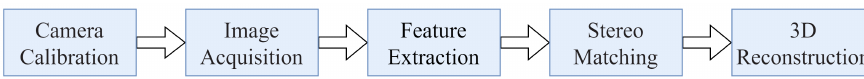
Figure 9. Flow chart of vision-based 3D reconstruction